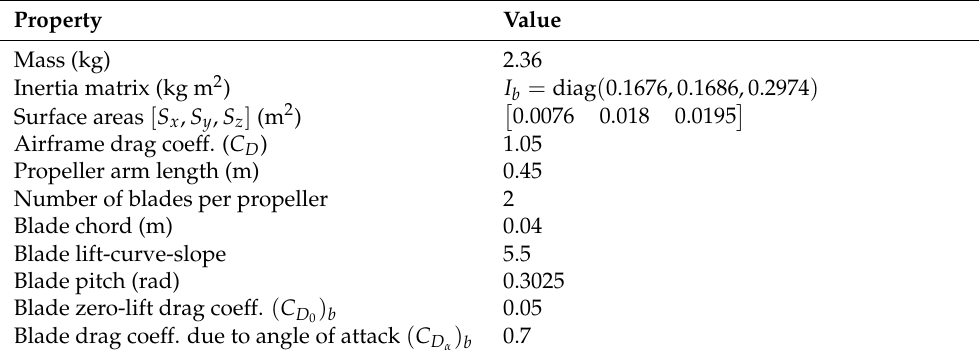
Table 1. Mass, inertia, and aerodynamic properties used to build mathematical model of the Drgan- flyer XPro quadrotor, ref. [41]. diag ( · ) denotes a diagonal matrix. Property Value Mass (kg) 2.36 Inertia matrix (kg m 2 ) I b = diag ( 0.1676,0.1686,0.2974